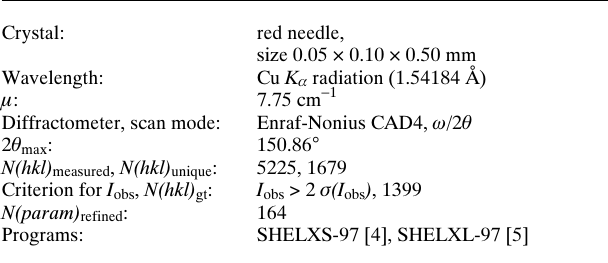
Table 1. Datacollection and handling.